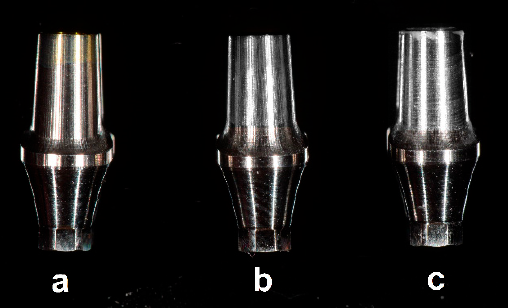
Figure 2. All the abutments were fabricated in identical external dimensions: ( a ) the Pre-Ti group; ( b ) the CAD-Ti group; ( c ) the AM-Ti group.